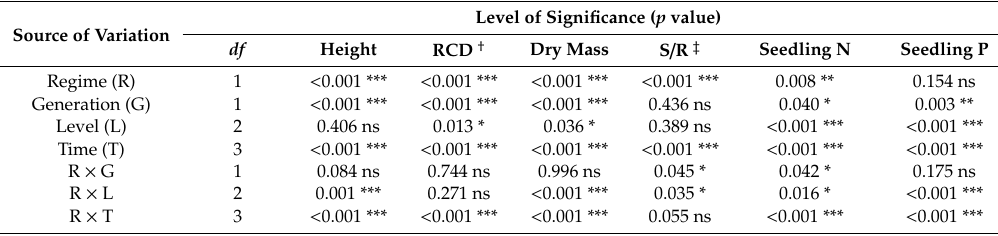
Table 1. Analysis of variance (ANOVA) on the e ff ects of fertilization regimes, seedling generations, fertilization levels, sampling times, and their interactions on seedling growth and nutrient concentrations.